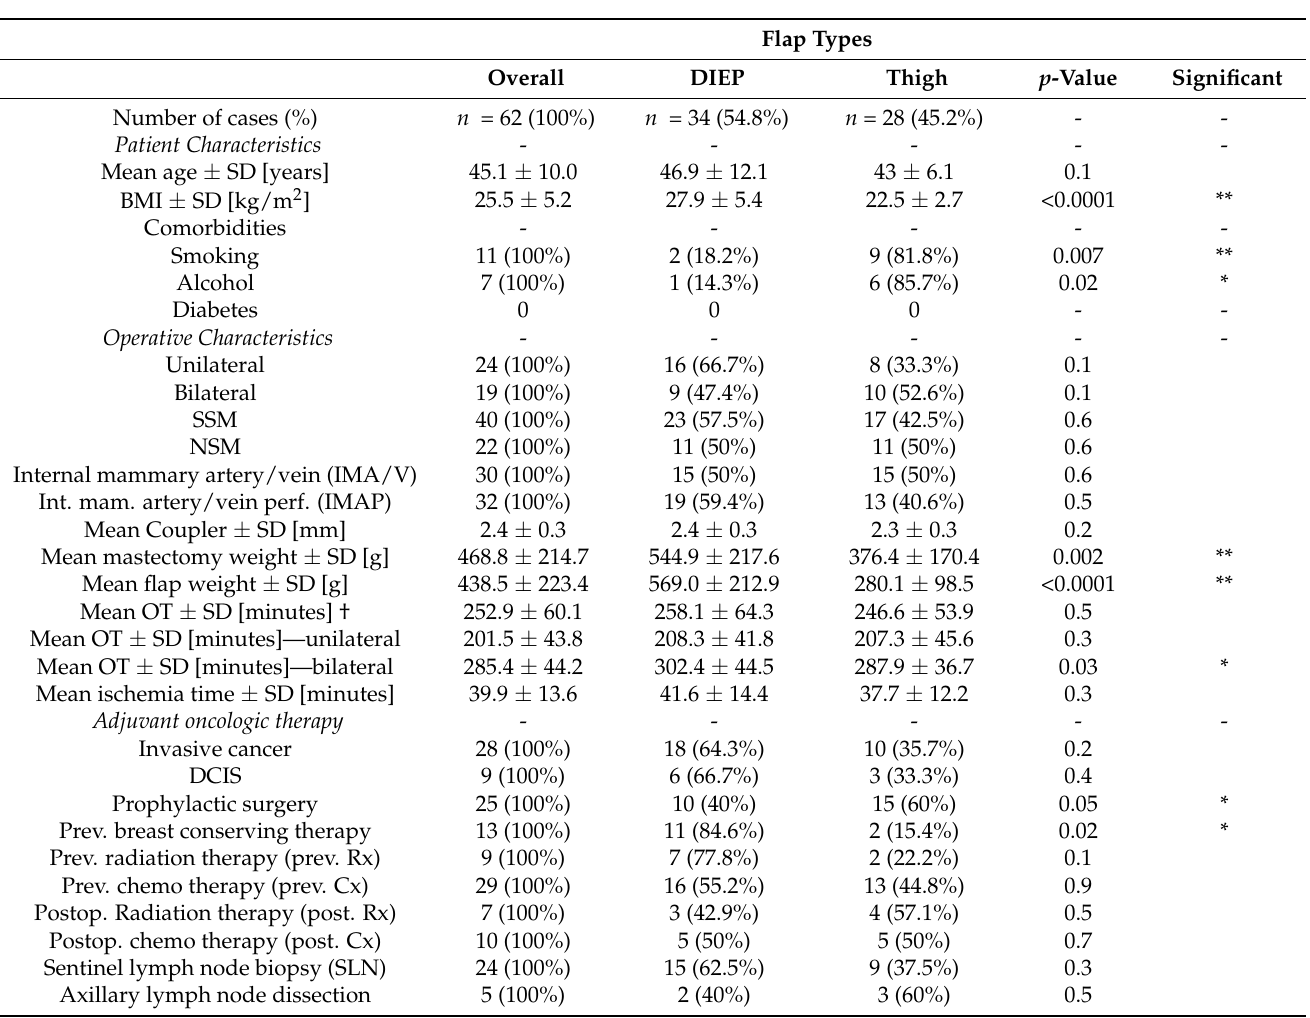
Table 1. Univariate analysis of patient, operative, and flap covariates between the DIEP and Thigh flap groups. Flap Types Overall DIEP Thigh p -Value